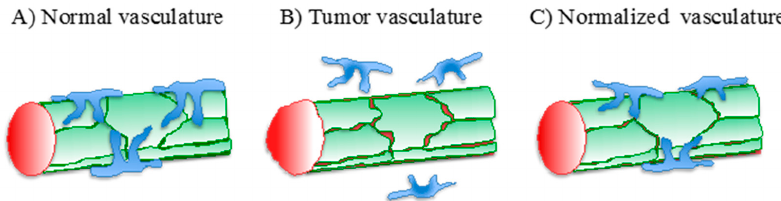
Figure 1. Aberrant tumor vessels and vascular normalization. ( A ) In normal vessels, endothelial cells (ECs) (green) are tightly adherent to each other, forming a continuous barrier. This, together with pericytes (blue), stabilizes the vessel wall; ( B ) In tumor vessels, ECs have an irregular morphology and are loosely attached to each other, resulting in intercellular gaps and, therefore, increased permeability; ( C ) Antiangiogenic treatments promote vascular normalization by restoring pericyte coverage and inter-endothelial adhesion, which revert vessel structure and function to a “normal-like” state. The red area indicates the vessel lumen.